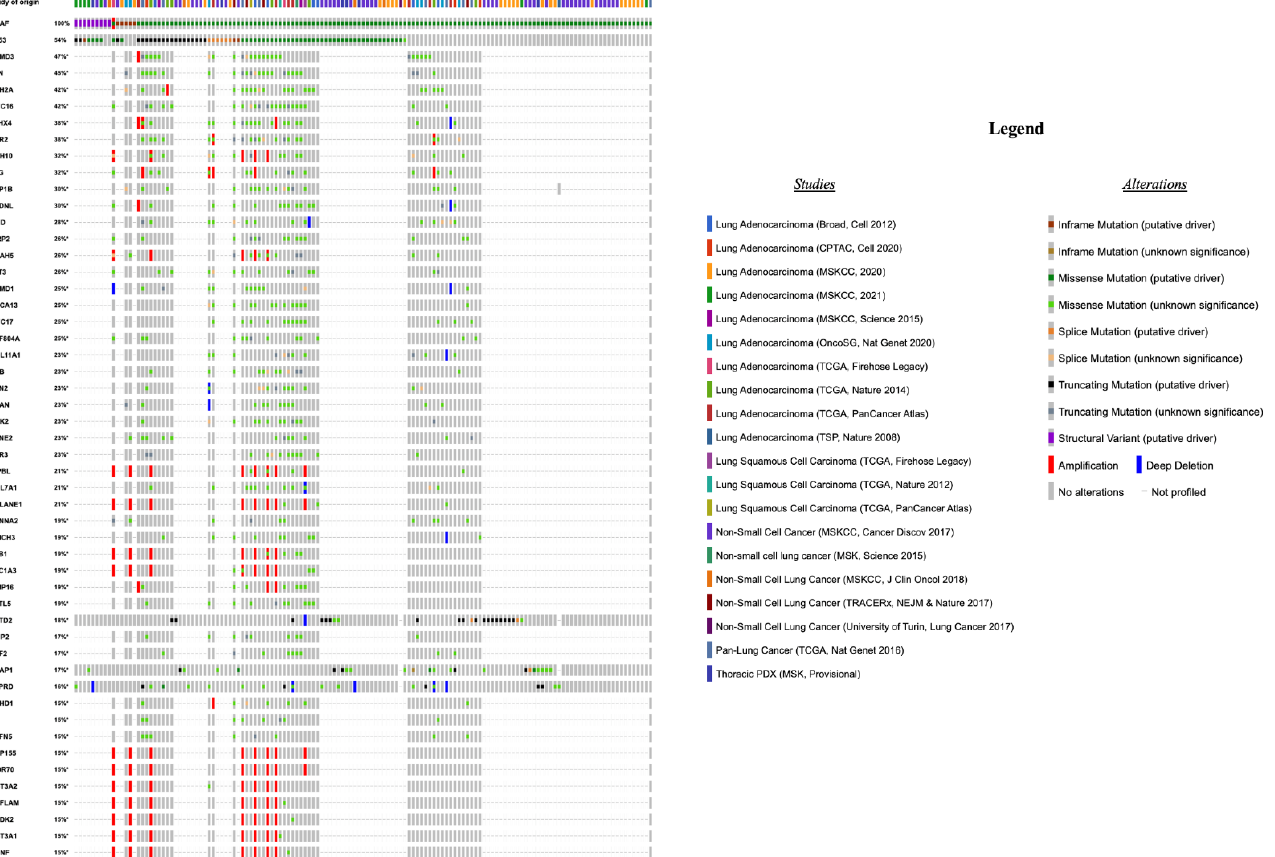
Figure 3. Top 50 most frequently altered genes in patients ( n = 139) harboring BRAF alterations of any defined functional class, the type of alteration, and the study of origin of each patient. SETD2 (20/45, 44%), CSMD3 (6/15, 40%) and TP53 (17/45, 38%) gene co-alterations were